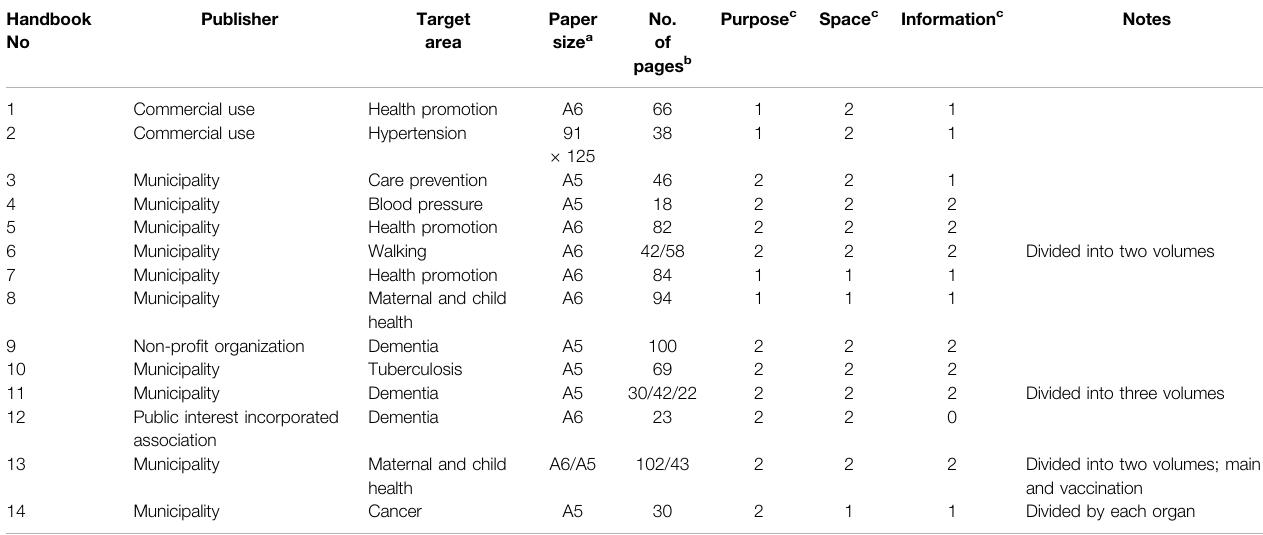
TABLE 1 | Function of the extracted health handbooks.